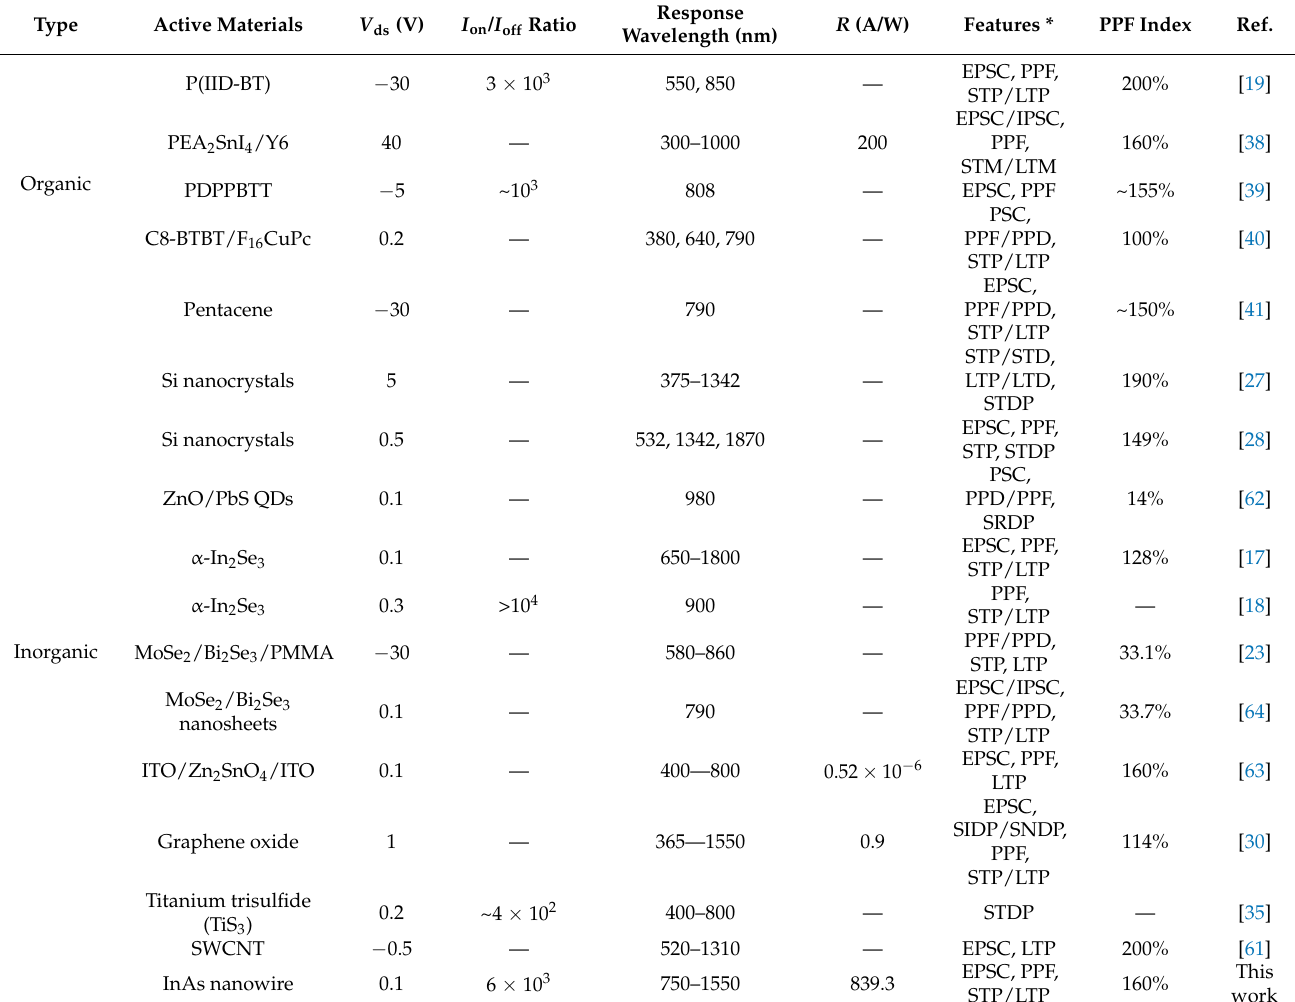
Table 1. A summary of recently published NIR light synapses.